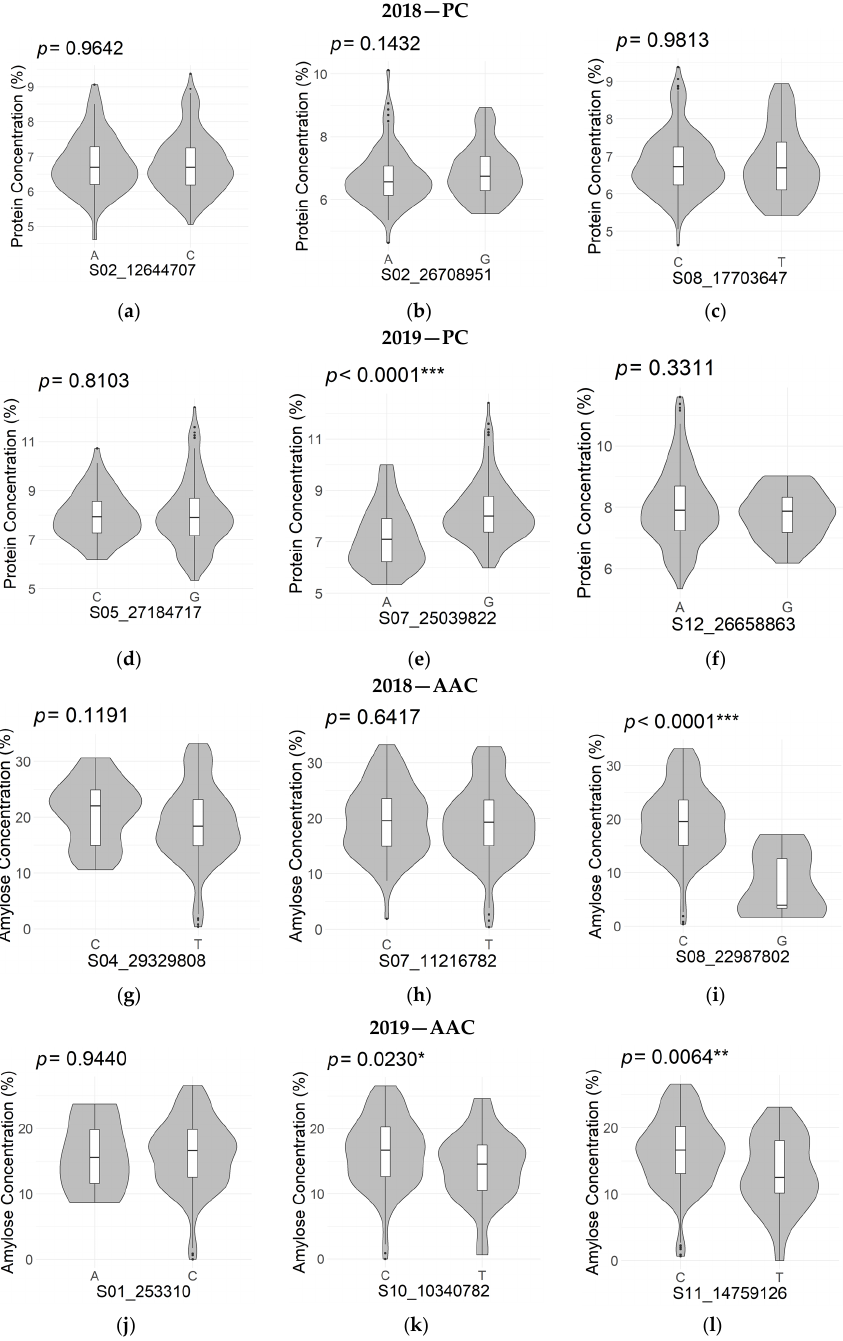
Figure 4. The allelic effect of the top three SNPs for protein concentration (PC) in 2018 ( a – c ) and 2019 ( d – f ) and the top three SNPs for apparent amylose concentration (AAC) in 2018 ( g – i ) and 2019 ( j – l ) are shown by boxplots within violin plots. The boxplot represents the interquartile range. The cen- tral line represents the median value. The gray shape on each side of the boxplot represents all measured data points, and the thickness represents the probability density of the data. The p -values of the two allelic effects on each SNP for PC and AAC are shown above each small plot. * Significant at p ≤ 0.05; ** significant at p ≤ 0.01; *** significant at p ≤ 0.001.